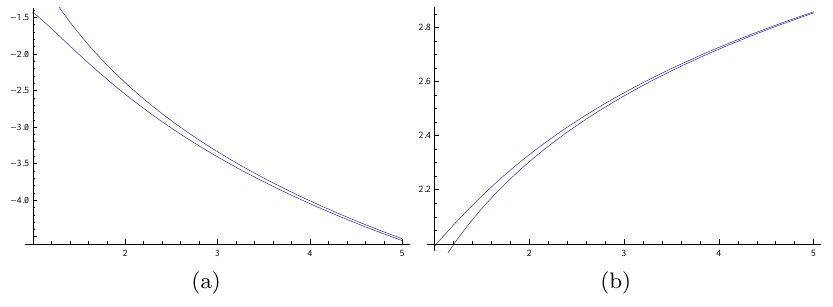
Figure 2 { (a) Plot of V (cid:11);(cid:12) ( X n : n ; t ) (bottom curve) and V (cid:11);(cid:12) ( X ; t ) (top curve) versus t (along horizontal axis) for Pareto distribution as described in Example 2 : Here we assume (cid:11) = 1 : 2 ; (cid:12) = 1 : 5 ; (cid:18) = 2 ; (cid:14) = 0 : 2 and n = 5 : (b) Plot of V (cid:11);(cid:12) ( X n : n ; t ) (top curve) and V (cid:11);(cid:12) ( X ; t ) (bottom curve) versus t (horizontal axis) for Pareto distribution. Assume (cid:11) = 0 : 2 ; (cid:12) = 1 : 2 ; (cid:18) = 2 ; (cid:14) = 0 : 2 and n = 5